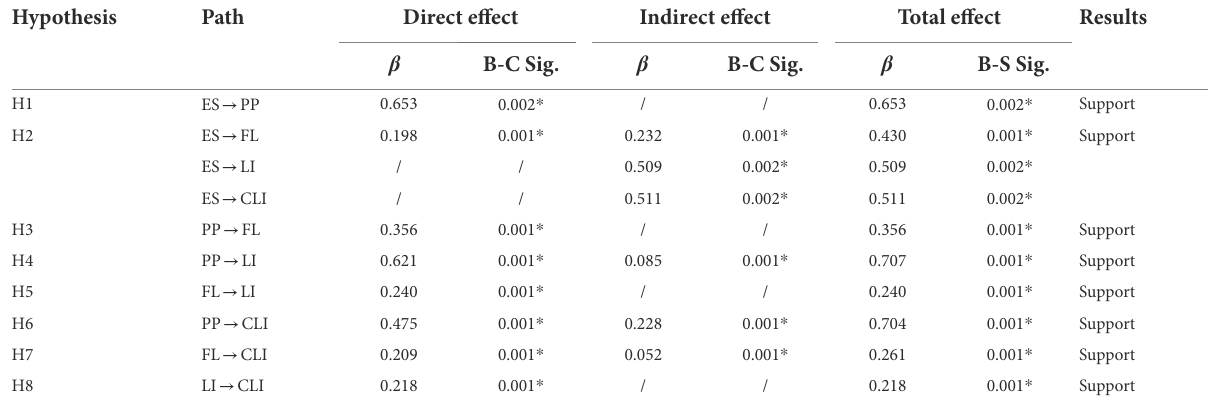
TABLE 9 Paths affect